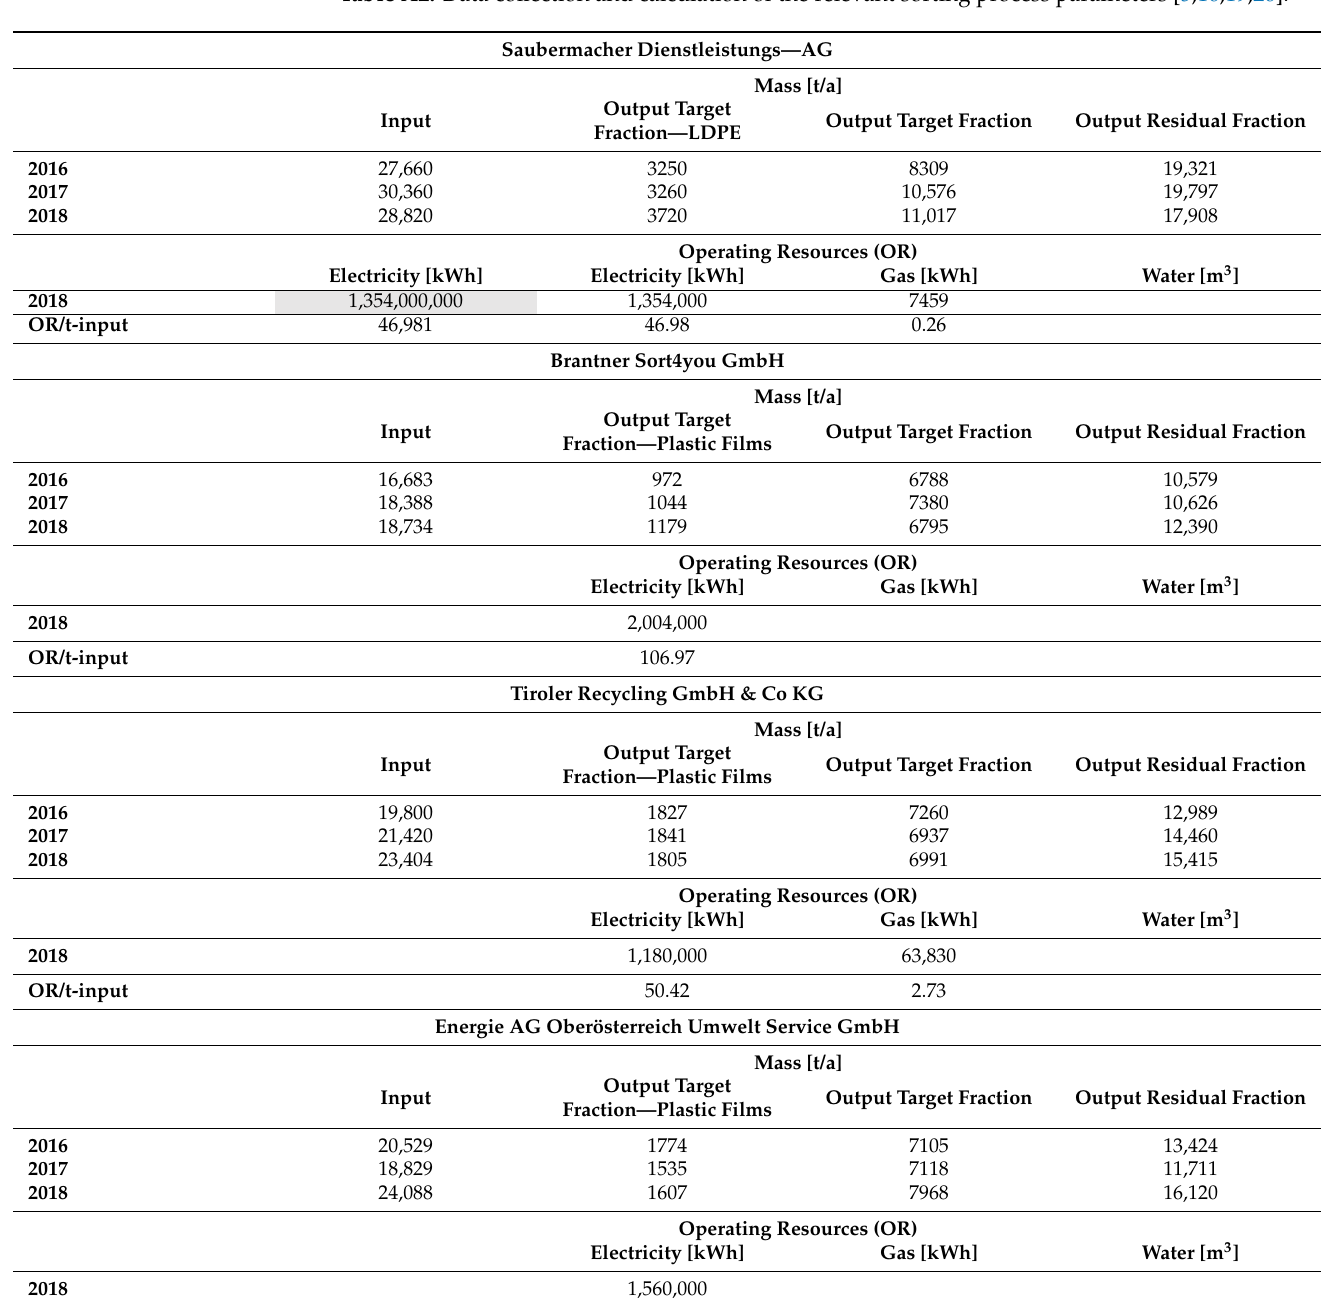
Table A2. Data collection and calculation of the relevant sorting process parameters